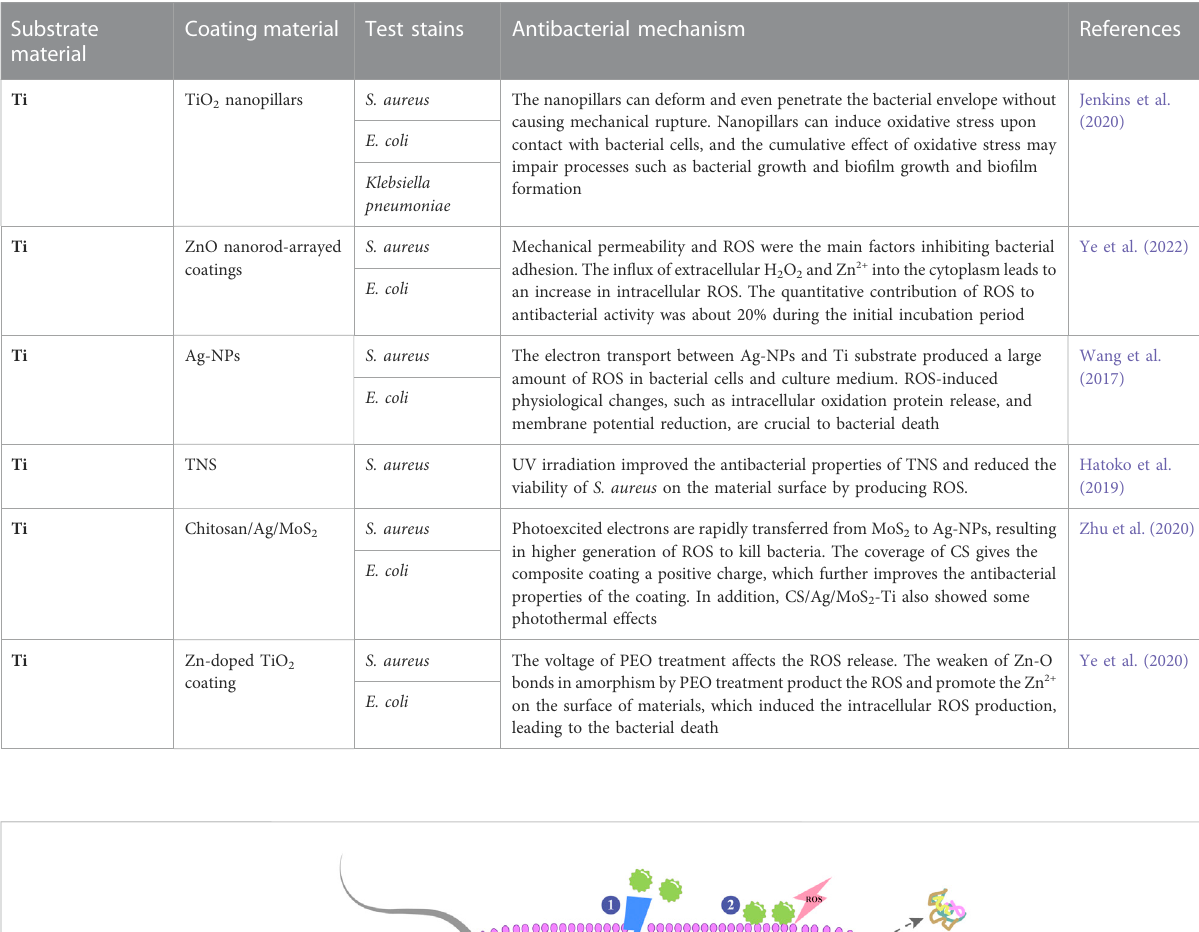
TABLE 4 Controlling oxidative stress by surface modi fi cation.